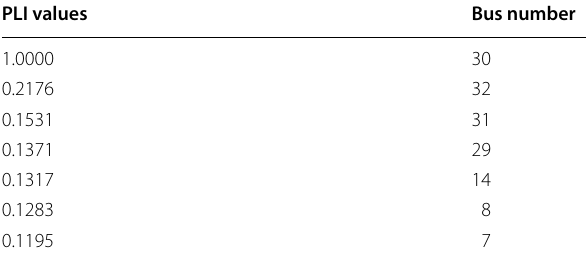
Table 2 PLI values for first ten elements of 33-bus system PLI values